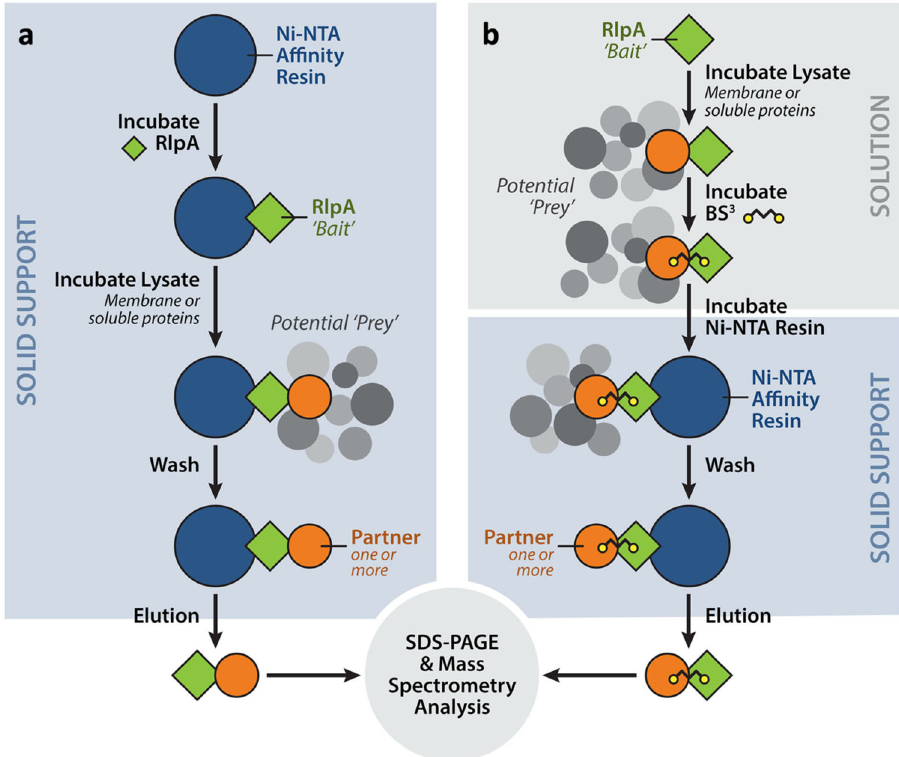
Fig. 2 RlpA- Δ 32 pulldown-enrichment strategy. a Pulldown without cross-linking and b with cross-linking. Gray and black shapes denote the P. aeruginosa proteome. Black chain with yellow-circle ends denotes BS 3 cross-linking between “ bait ” (RlpA) and “ prey ” (from the proteome). “ Prey ” protein denotes any available protein binding to “ bait ”